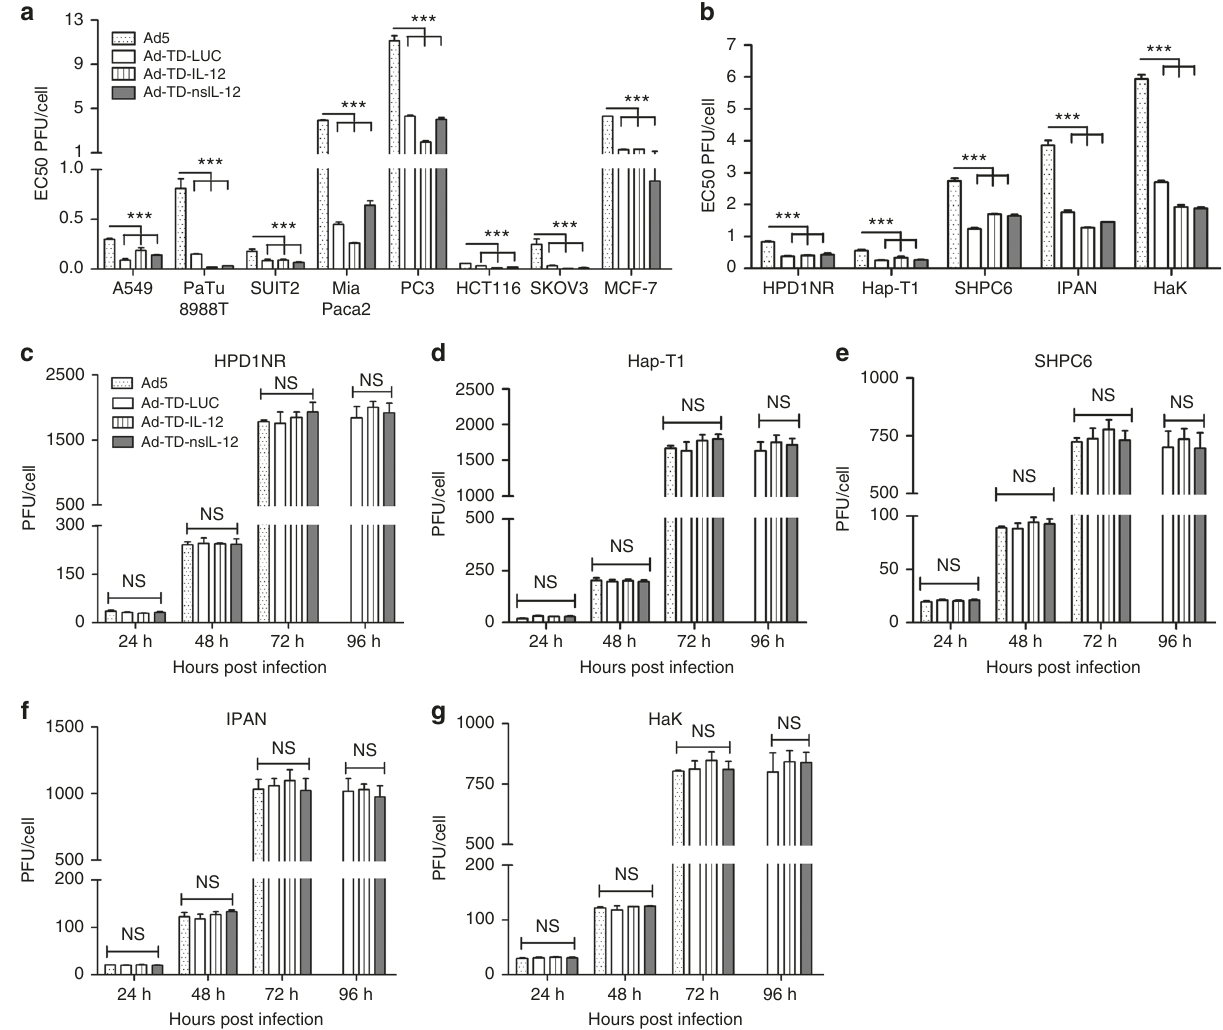
Fig. 2 Ad-TD-LUC and IL-12-armed viruses replicate in and are cytotoxic cancer cell lines. a , b To assess virus cytotoxicity, cell proliferation assays (Promega) were carried out in all human a and Syrian hamster b tumor cell lines. Cells were infected with Ad5, Ad-TD-LUC or Ad-TD-IL-12 or Ad-TD-nsIL- 12 and incubated for 6 days at 37 o C. The amount of virus particles required to kill 50% of the cells is shown as EC50 (PFU/cell) and shown as mean and SEM compared using an independent t -test. c − g Replication assays were carried out in hamster pancreatic cancer cell lines, HPD1NR, Hap-T1, SHPC6 and IPAN, and hamster kidney cancer cells (HaK) at an MOI of 5 PFU/cell. Mean and SEM are shown for each group and compared using an independent t - test. * p < 0.05, ** p < 0.01, *** p